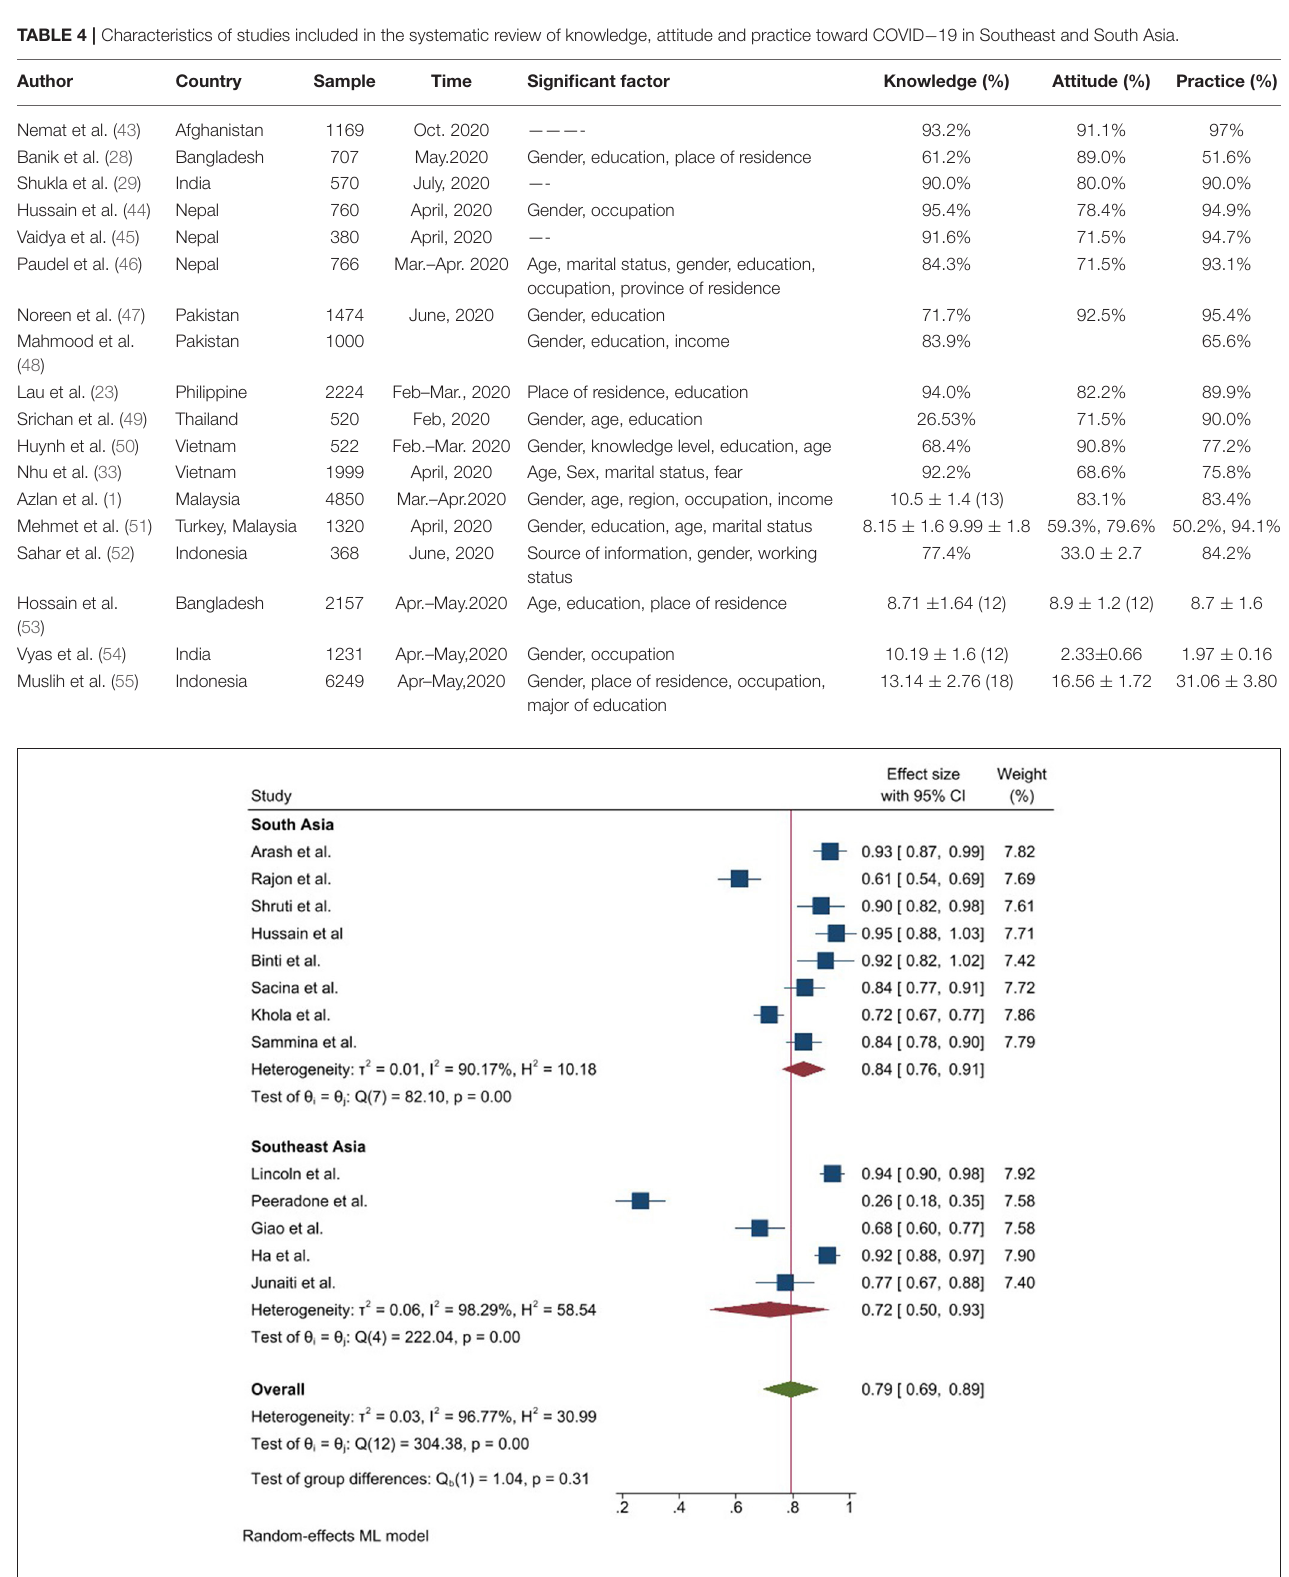
FIGURE 4 | Prevalence of good knowledge toward COVID-19 epidemic in Southeast and South Asia, stratified by region.